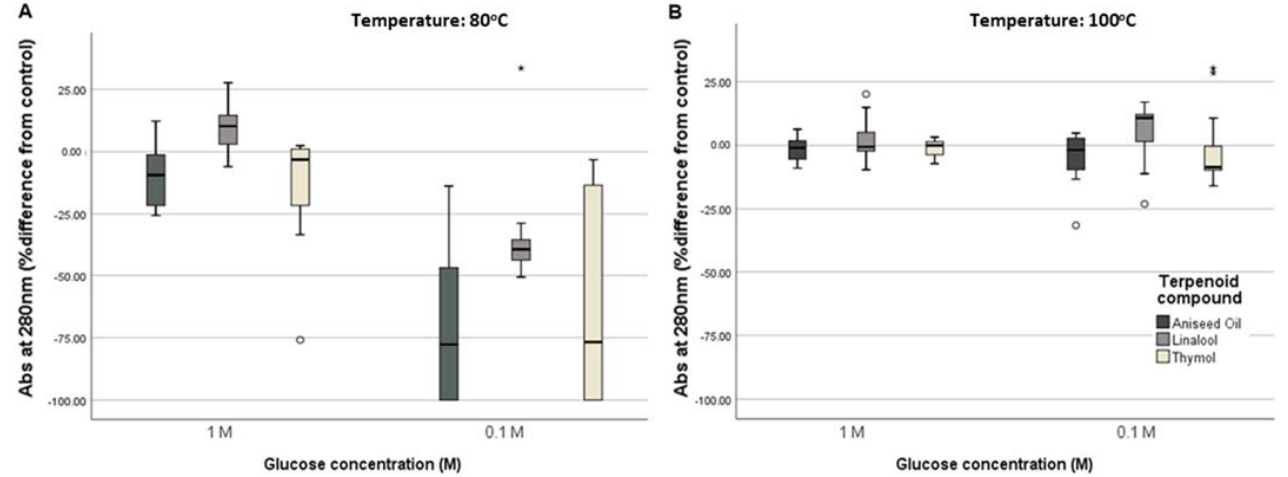
Figure 2. The effect of terpenoid compounds on early glycation products formation (280 nm) in heated glucose/lysine solutions at 0.1 M and 1 M glucose at pH 7.2 and ( A ) 80 °C and ( B ) 100 °C. Symbols (*, **, °) outside the boxplots indicate outliers.